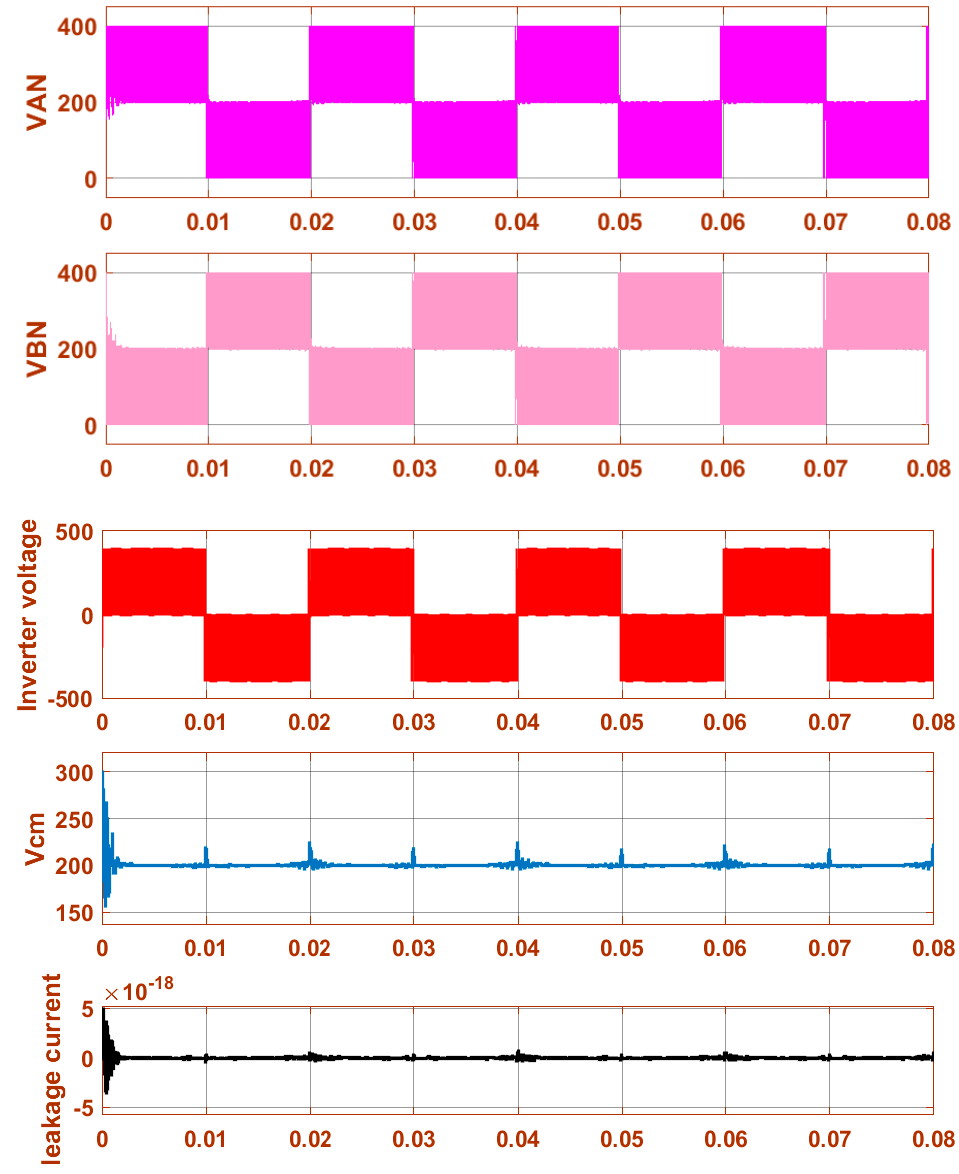
Figure 14. Waveform of V AN , V BN , inverter voltage and V cm , leakage current of H6 I inverter.